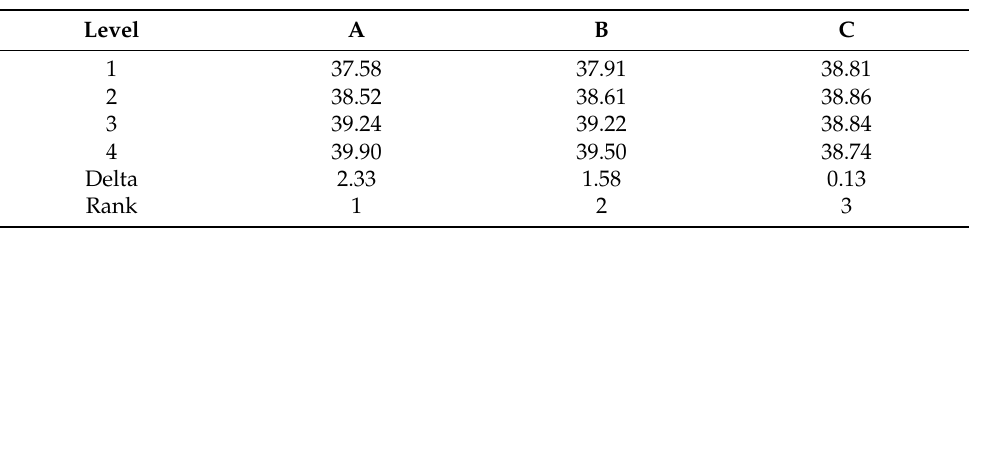
Table 8. Parameter ranking for S/N of failure